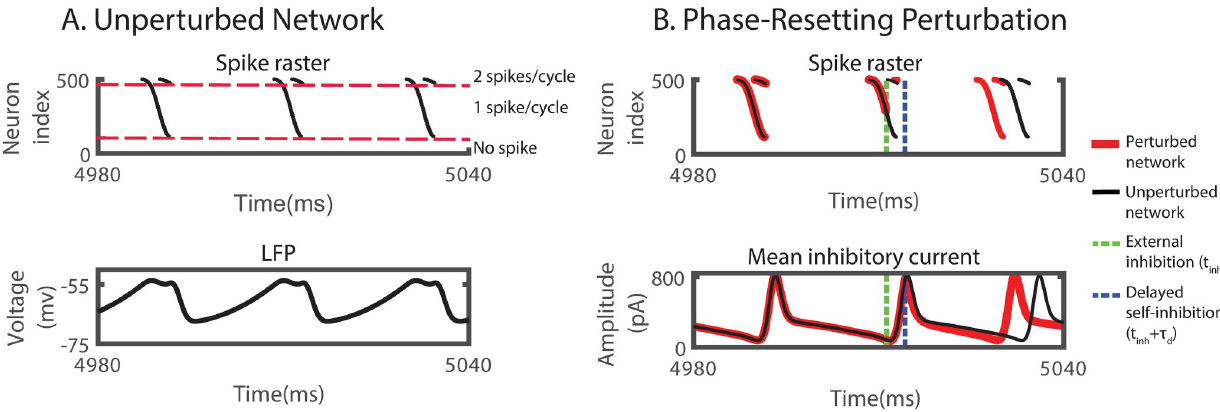
Fig 1. ING-rhythm can be advanced by inhibition while individual neurons are delayed. (A) Top: spike raster of neurons spiking sequentially in the order of their input strength (increasing with neuron index). Bottom: mean voltage across the network (LFP). (B) External inhibition advanced the rhythm. Top: raster plot of spikes without (black) and with (red) external inhibitory pulse. Bottom: Average of the total inhibitory current each neuron received from the other neurons within the network. I ( I ) = 20.4 pA, C ð I Þ ¼ 0 : 15 , f network = 47 Hz. In (B), perturbations were made with a square-wave inhibitory V current pulse with duration 0.1 ms and amplitude 3200 pA to each neuron, resulting in a 4 mV rapid hyperpolarization.